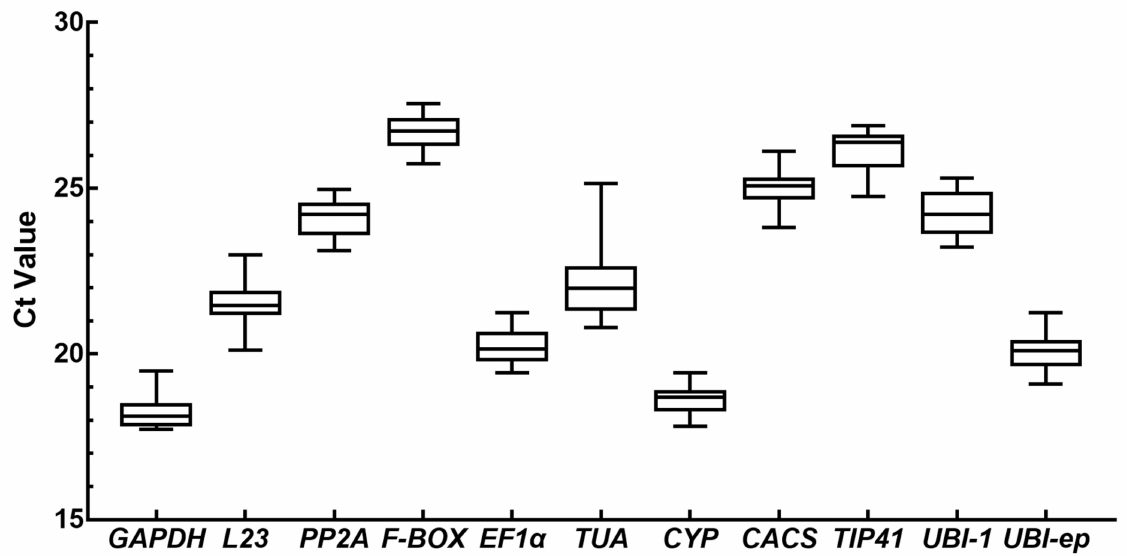
Figure 4. Expression levels of the eleven candidate reference genes evaluated in prunus necrotic ringspot virus (PNRSV)-infected C. sativus . Values are given as the cycle threshold (Ct, mean of triplicate samples) and are inversely proportional to the amount of template. The three lines of the box represent the 25th quartiles, median, and 75th quartiles. The whiskers represent minimum and maximum